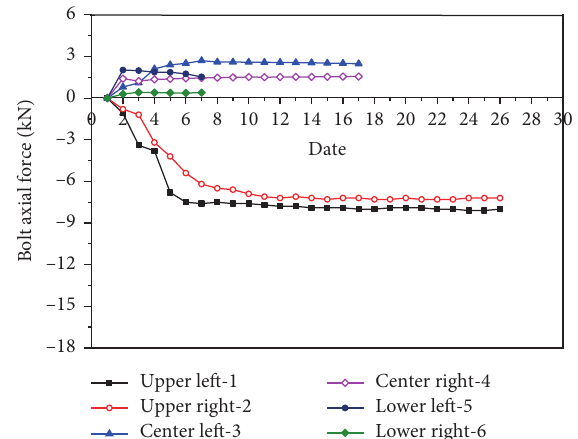
Figure 28: Section 918 feet reinforcement bolt axis force change